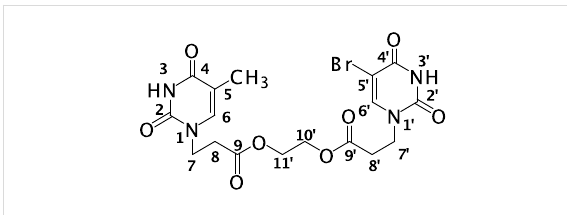
Figure 1: Protons assignment in NMR spectrum of the model ester- conjugated nucleoside ( 4 ).